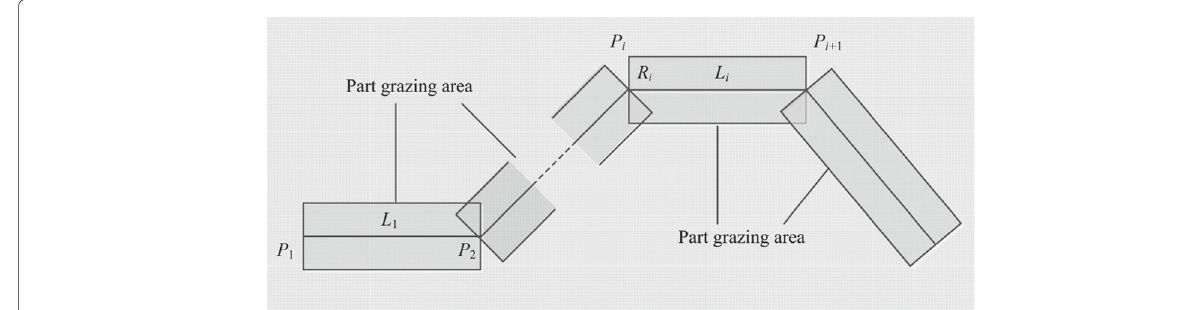
Fig. 4 Schematic diagram of part grazing area generation method